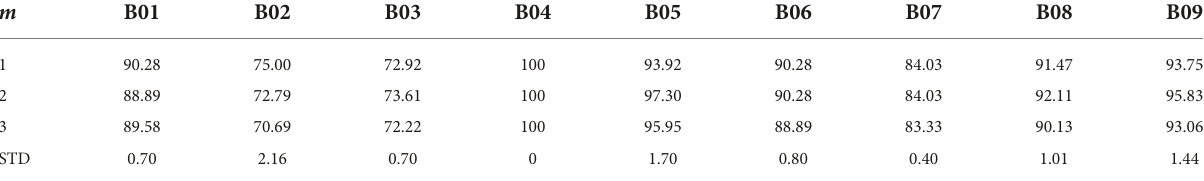
TABLE 8 Performance comparison of different values of m for our method, using dataset